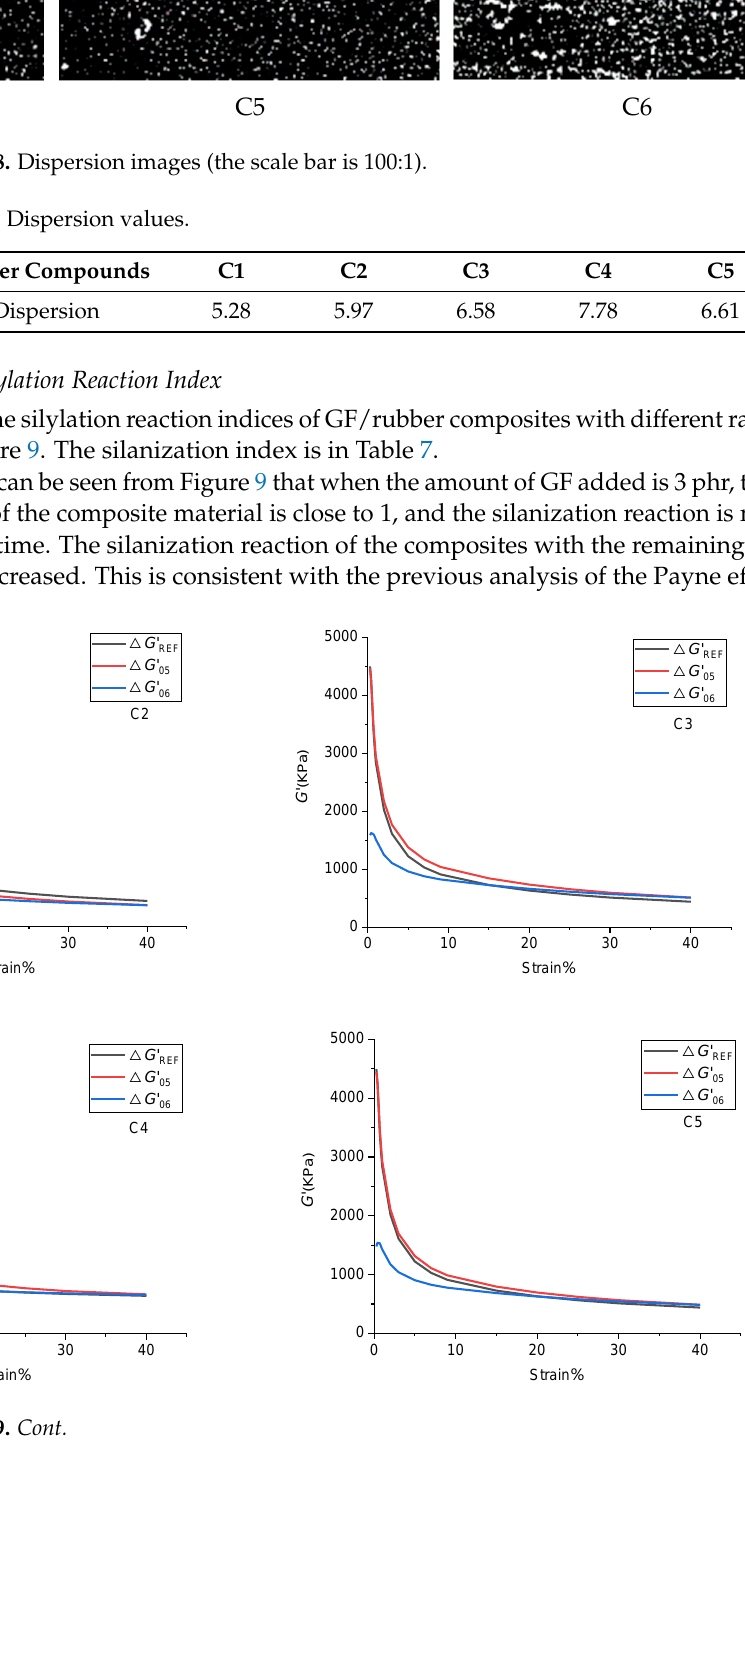
Figure 9. Silylation reaction image. Table 7. Silylation reaction index. Compounding Rubber